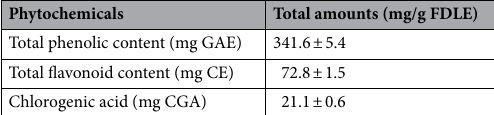
Table 1. Total amounts of major phytochemicals in FDLE.